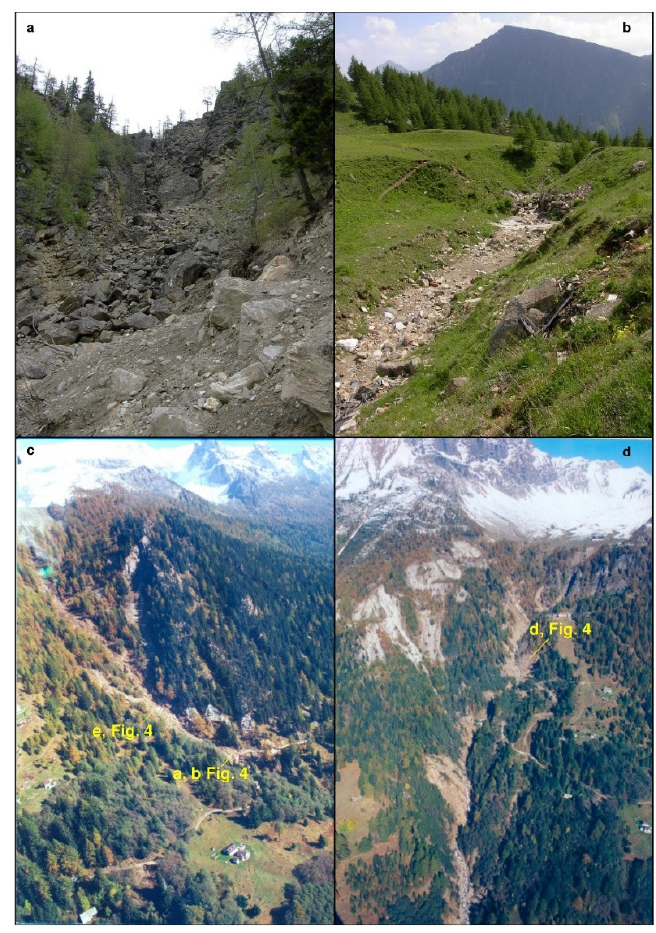
Figure 6. The Rio Croso hydrographic basin before the event of the 12 August 2019—( a ) the Croso stream in 2006 with the very evident steepness and abundant debris; ( b ) the incision within the terrace of the Alpe Ciamporino; ( c , d ) the Croso stream after the October 2000 event (see details in Figure 7).